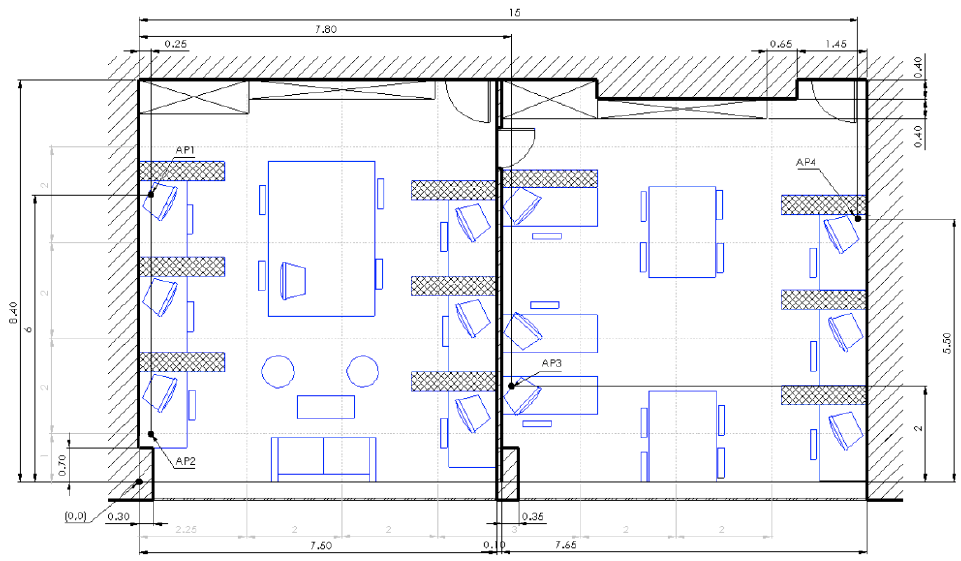
Figure 14. Evaluation environment—multi-room.